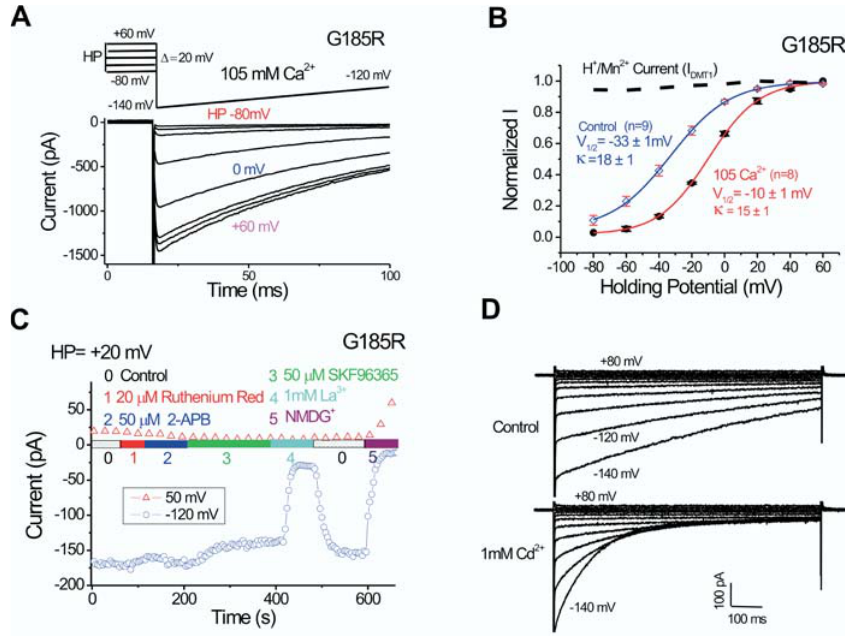
Figure 4. Voltage Dependence and Phar- macological Properties of I G185R (A) Whole-cell currents recorded in 105 mM [Ca 2 þ ] o were dependent on holding potential before the voltage ramps ( (cid:1) 140 to (cid:1) 120 mV shown). For clarity, only the first 20 ms of the 4 s-long holding potential is shown. (B) Voltage dependence of I G185R in control solution and 105 mM [Ca 2 þ ] o